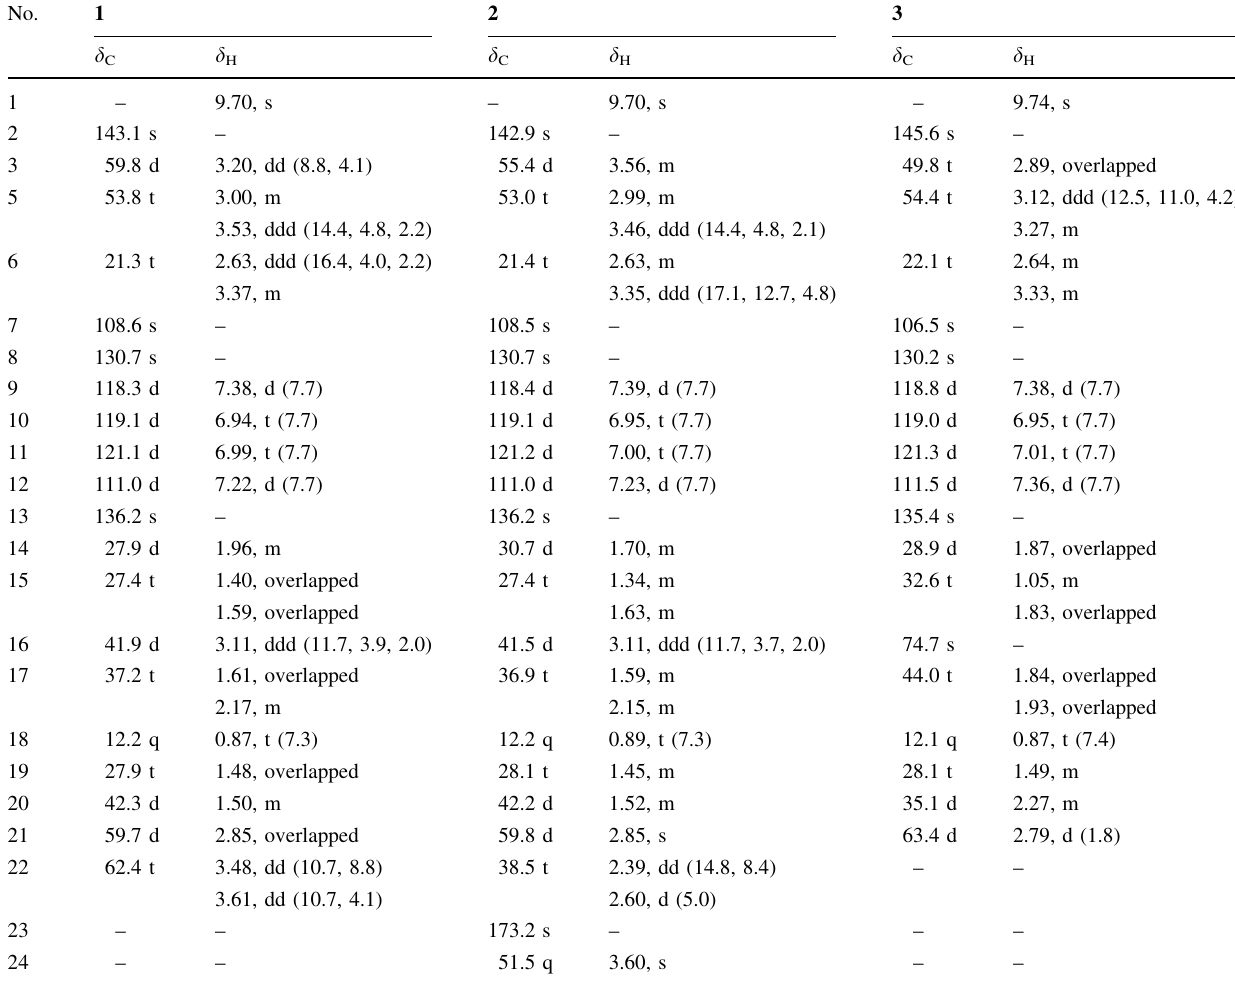
Table 1 1 H (400 MHz) and 13 C (125 MHz) NMR data for compounds 1 – 3 ( d in ppm, J in Hz) a